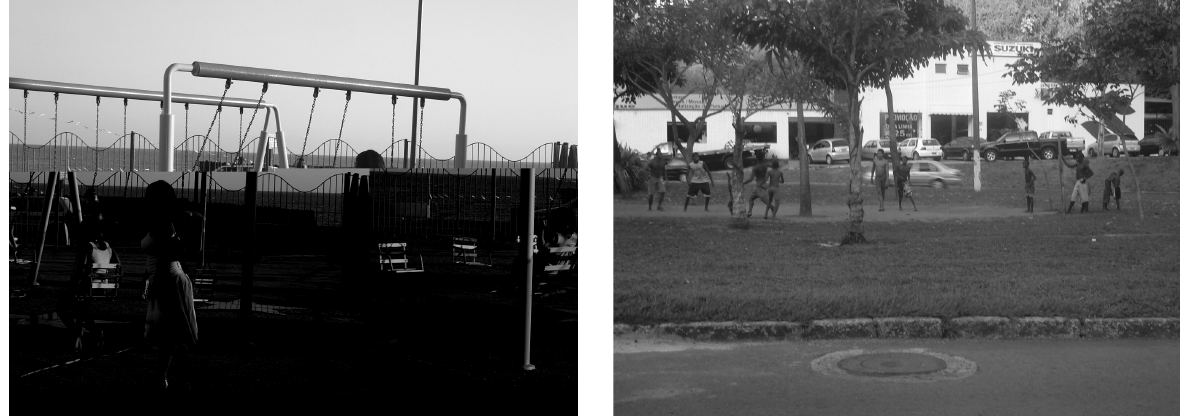
Figura 2 . Tipos de participação dos